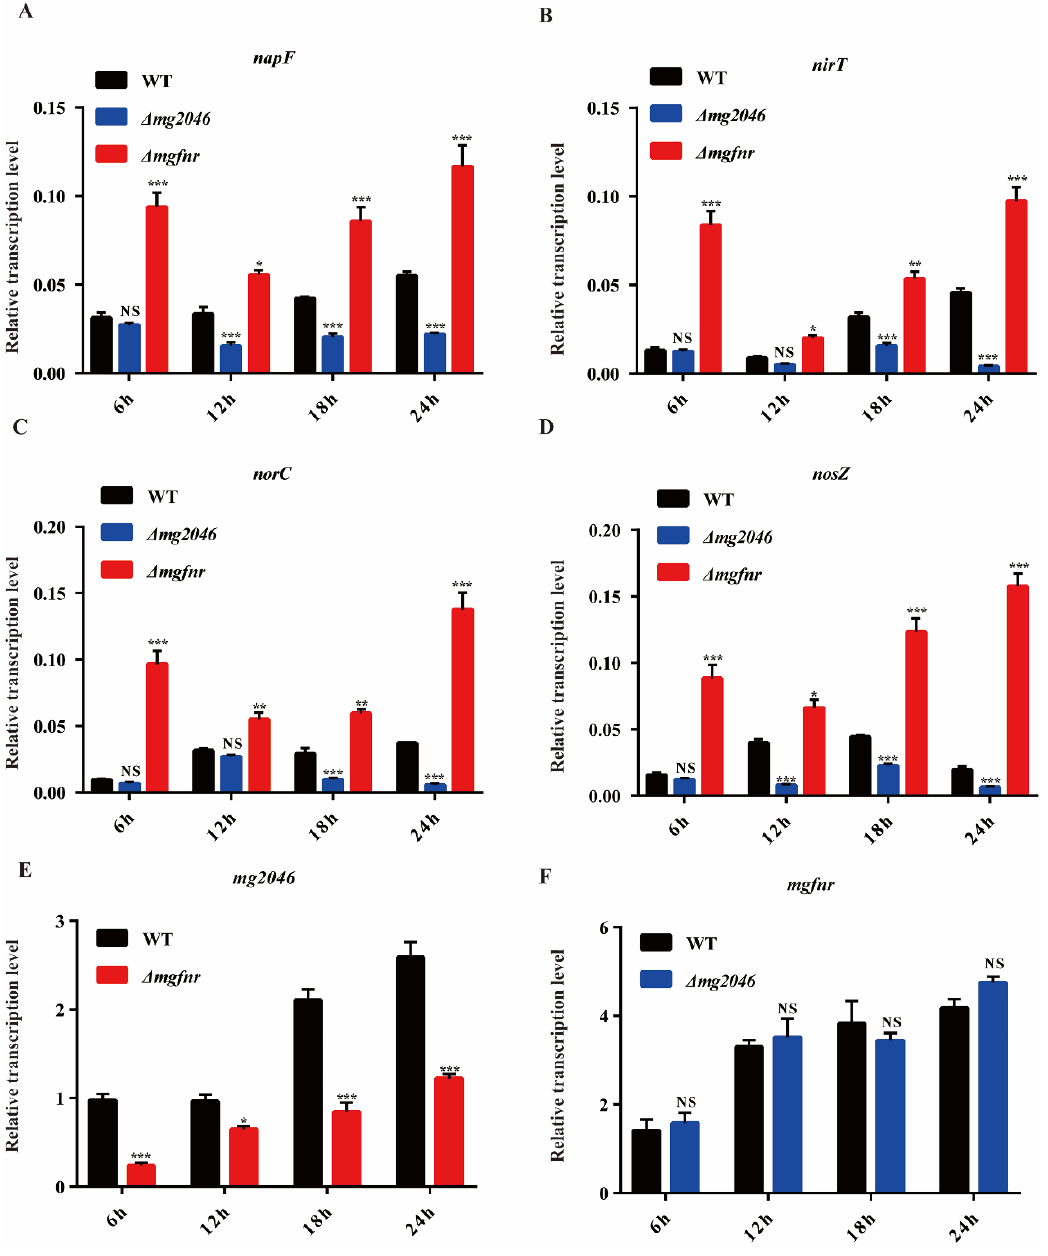
Figure 2. Relative transcription levels of dissimilatory denitrification genes in WT, Δmg2046 ,